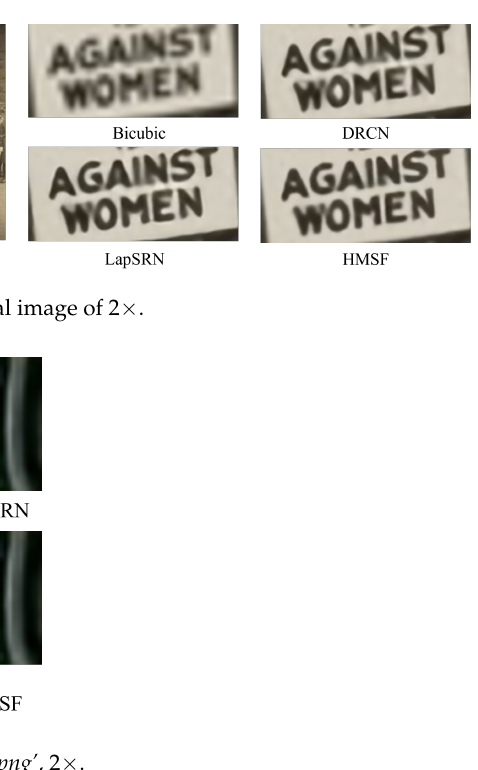
Figure 16. Visual test on real LR image ‘Cat.png’ , 2 × .